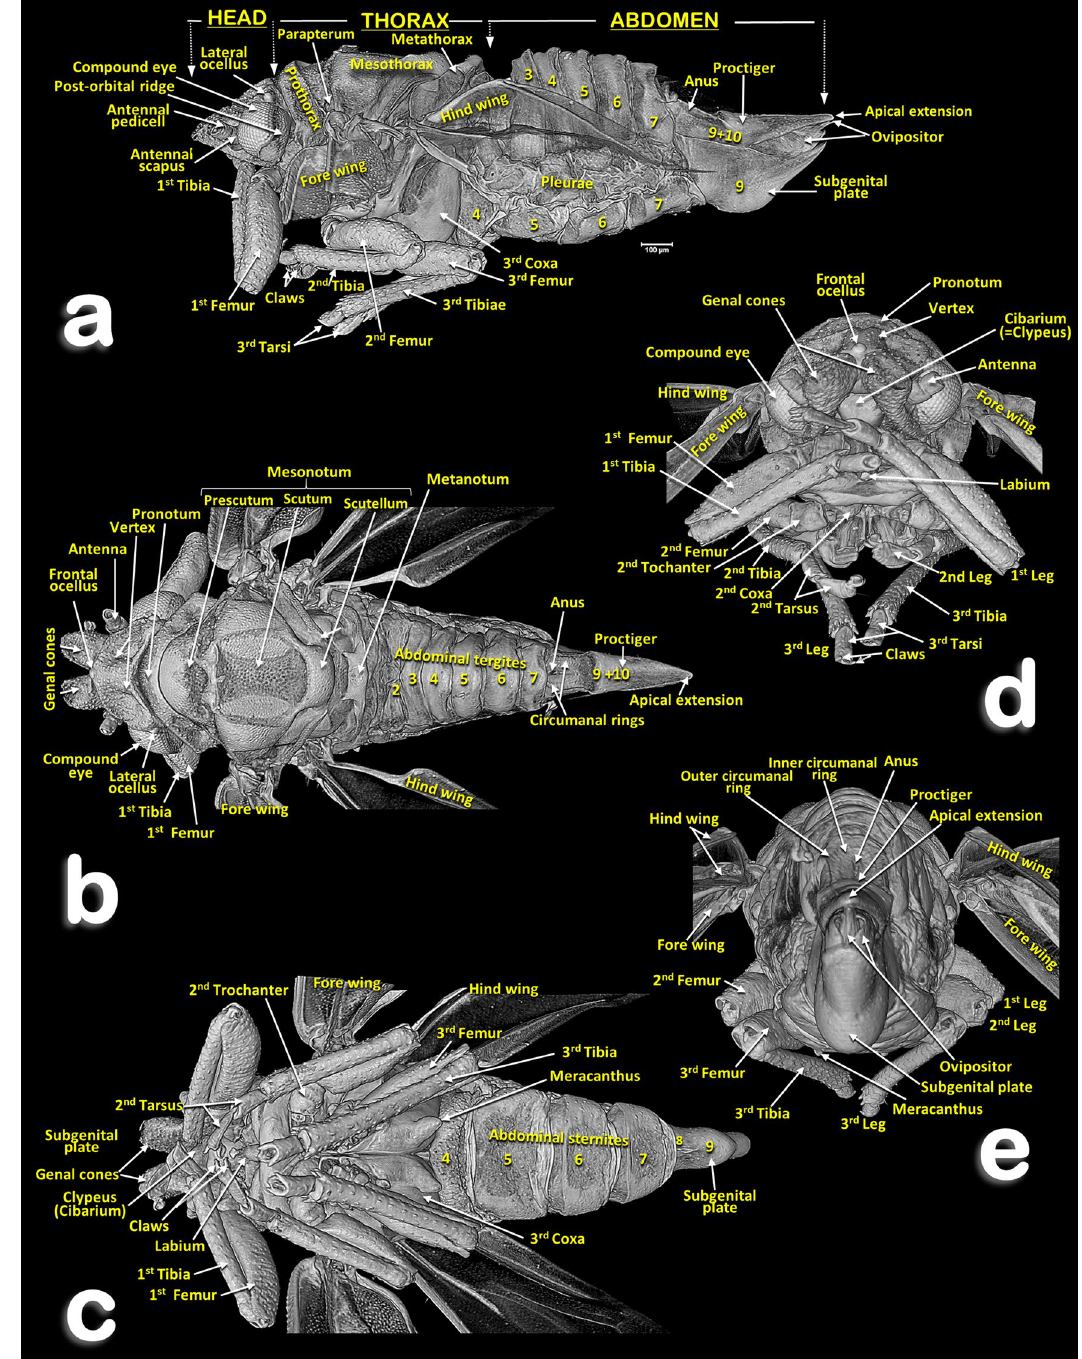
Figure 2. Volume-rendered images of the general external anatomy of a female Diaphorina citri in different views. Left-lateral ( a ), dorsal ( b ), ventral ( c ), frontal ( d ) and posterior ( e